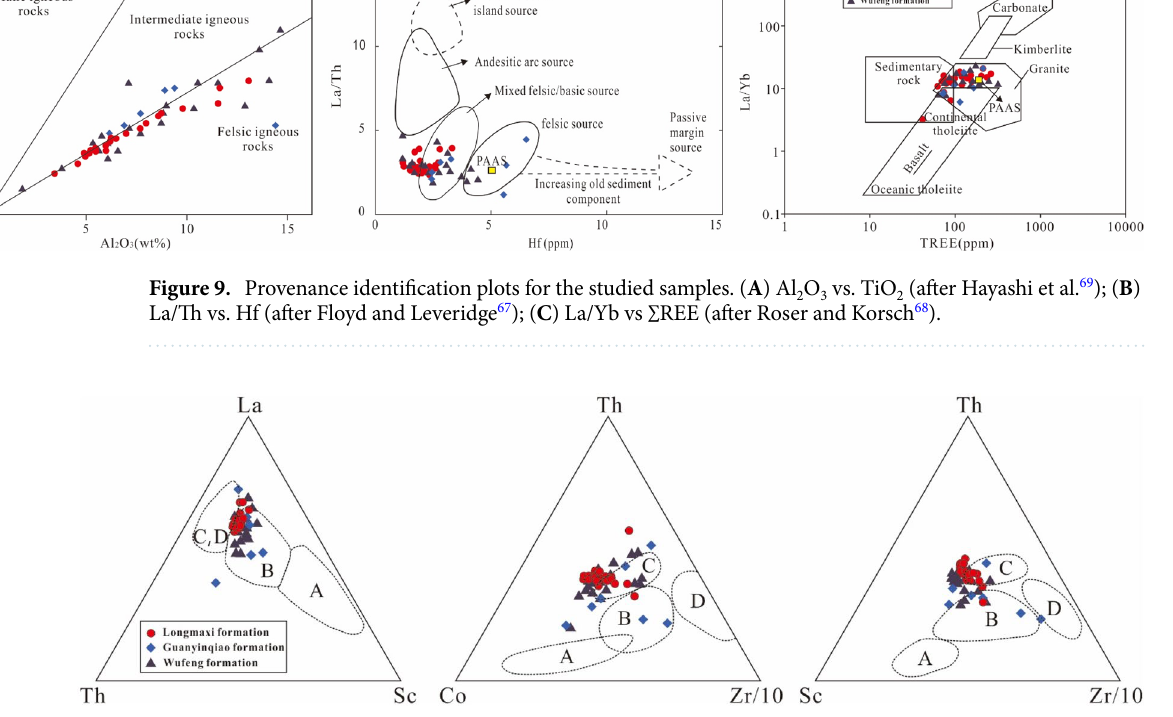
Figure 10. La–Th–Sc, Th–Co–Zr/10 and Th–Sc–Zr/10 plots of the shales and carbonaceous marls from the Wufeng-Longmaxi formations in the Xindi No. 2 well for tectonic discrimination. Dotted lines represent the dominant fields for sedimentary rocks from various tectonic settings (Bhatia and Crook 70 ): ( A ) oceanic island arc; ( B ) continental island arc; ( C ) active continental margin; ( D ) passive